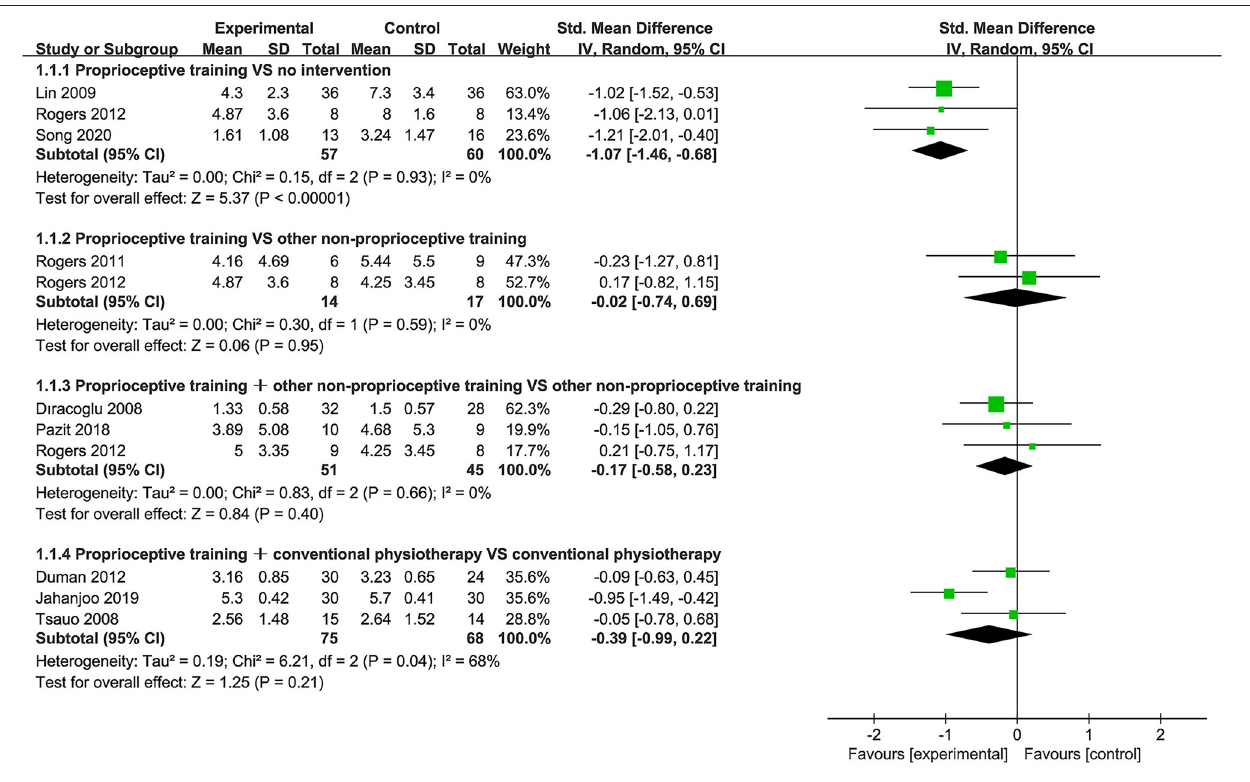
FIGURE 2 | Forest plot of meta-analysis on pain.